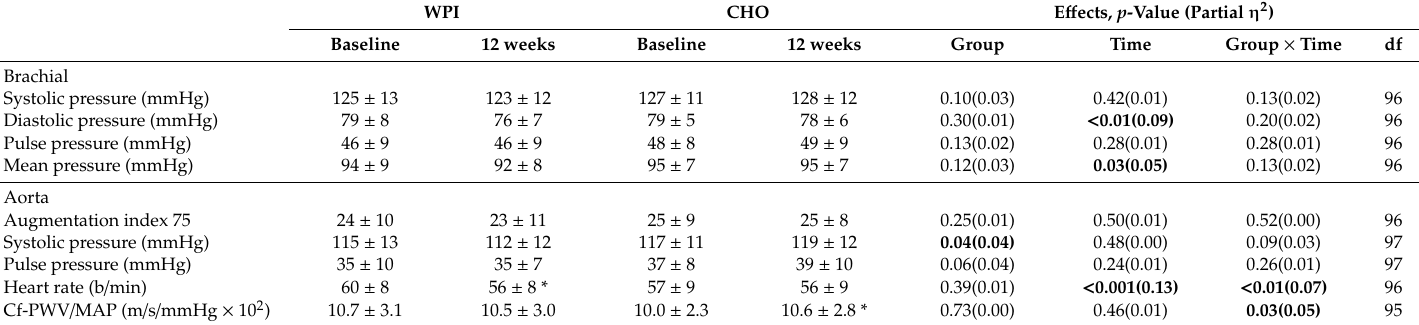
WPI, whey protein isolate; CHO, carbohydrate; Cf-PWV / MAP, carotid femoral pulse wave velocity relative to mean arterial pressure; * p < 0.05 vs. Baseline. Bold highlights statistically significant e ff